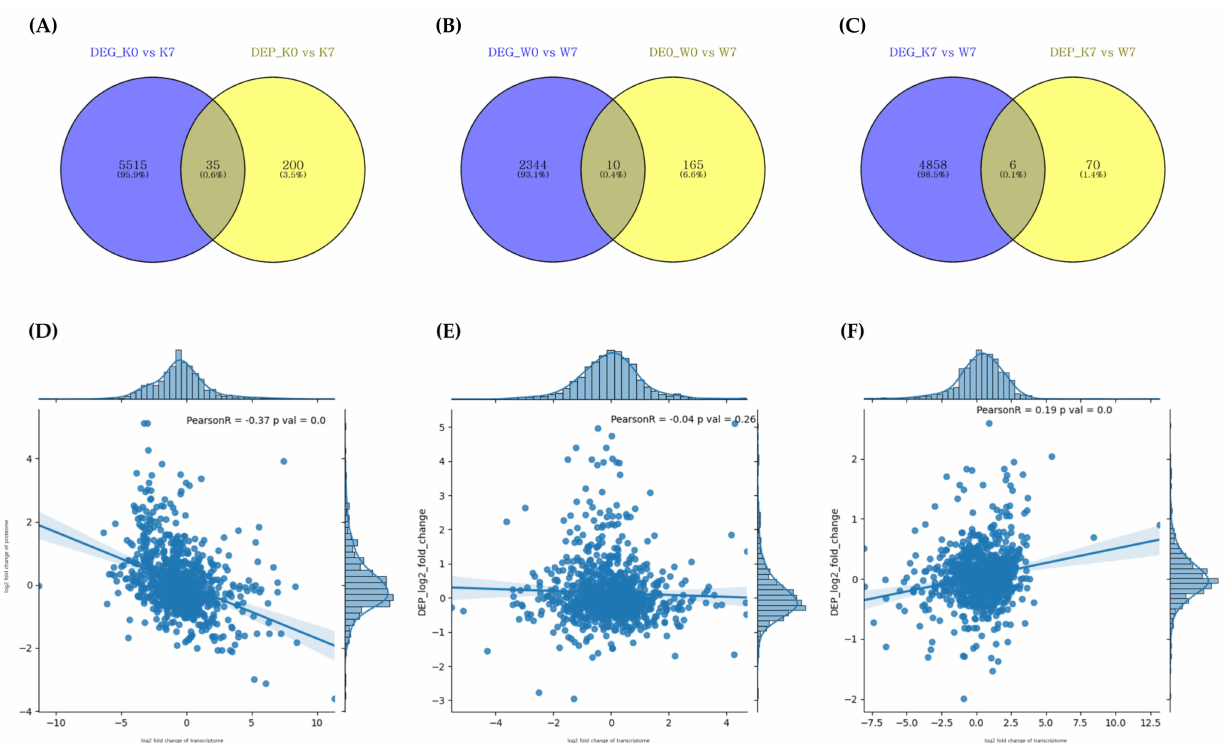
Figure 7. Correlation analysis between proteome and transcriptome by DEG/DEP expression correlation Venn diagram ( A – C ). DEG_comparison group and DEP_comparison group